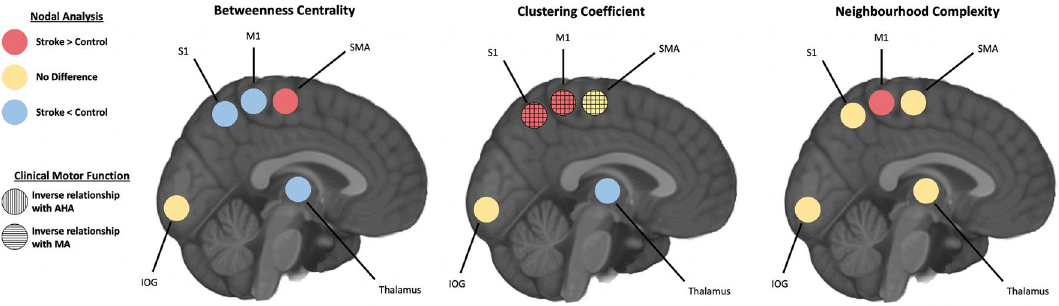
Figure 3. Sensorimotor network node analysis. Sensorimotor node differences between the dominant hemisphere of controls to the non-lesioned, intact hemisphere of both stroke groups are shown. For the simplicity of the diagram, both arterial and venous strokes were combined as they displayed no differences from each other in any of the nodes. Red circles represent the nodes where both stroke groups showed higher values compared to controls, yellow representing no difference, and blue representing nodes of lower values compared to controls. Vertical lines represent an inverse relationship between the respective graph theory metric at the node of interest and the AHA. Horizontal lines represent the same inverse relationship with the node, but in relationship to MA instead. S1 primary sensory cortex, M1 primary motor cortex, SMA supplementary motor area, IOG inferior occipital gyrus, AHA assisting hand assessment, MA Melbourne